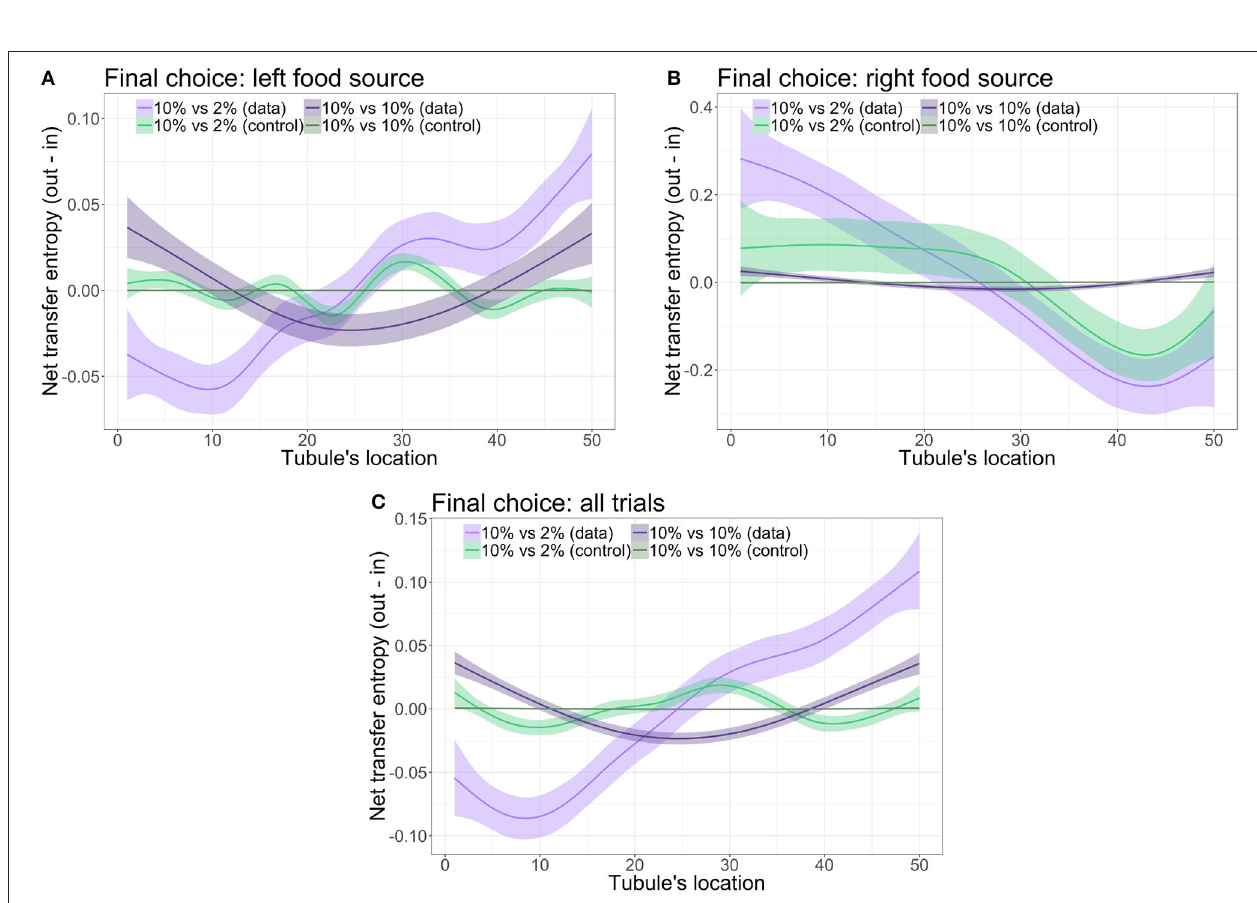
FIGURE 4 | Net transfer entropy at the contractile locations along the length of the tubule ( { 1, ... , 50 } ) for (A) trials with final choice being the left food source, (B) trials with final choice being the right food source, and (C) all trials such that the chosen food source is on the left and rejected food source on the right. Parameters: 10 vs. 10% w/v ( k = 3, smoothing span 0.001), 10 vs. 2% w/v ( k = 10, smoothing span 0.006).